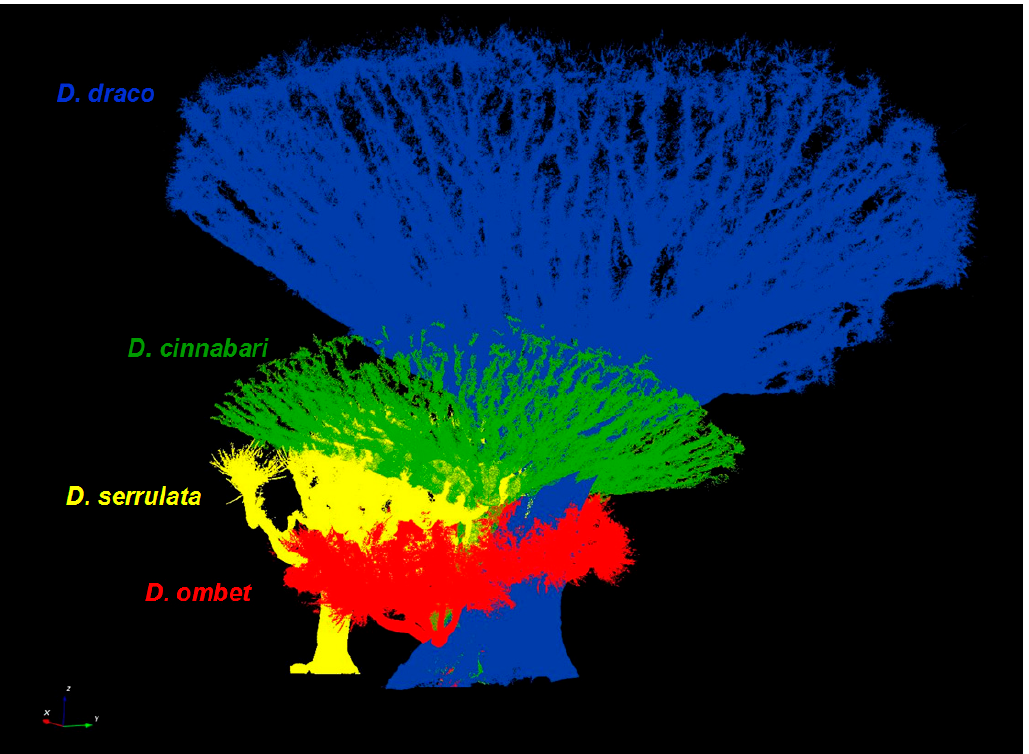
Figure 10. Comparison of the largest examples of created 3D tree point clouds of all studied species in the vertical view depicted with the same scale.